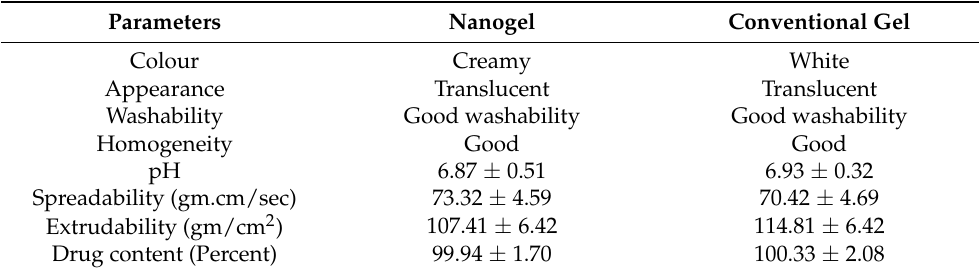
Table 4. Results of evaluation for nanogel and conventional gel.